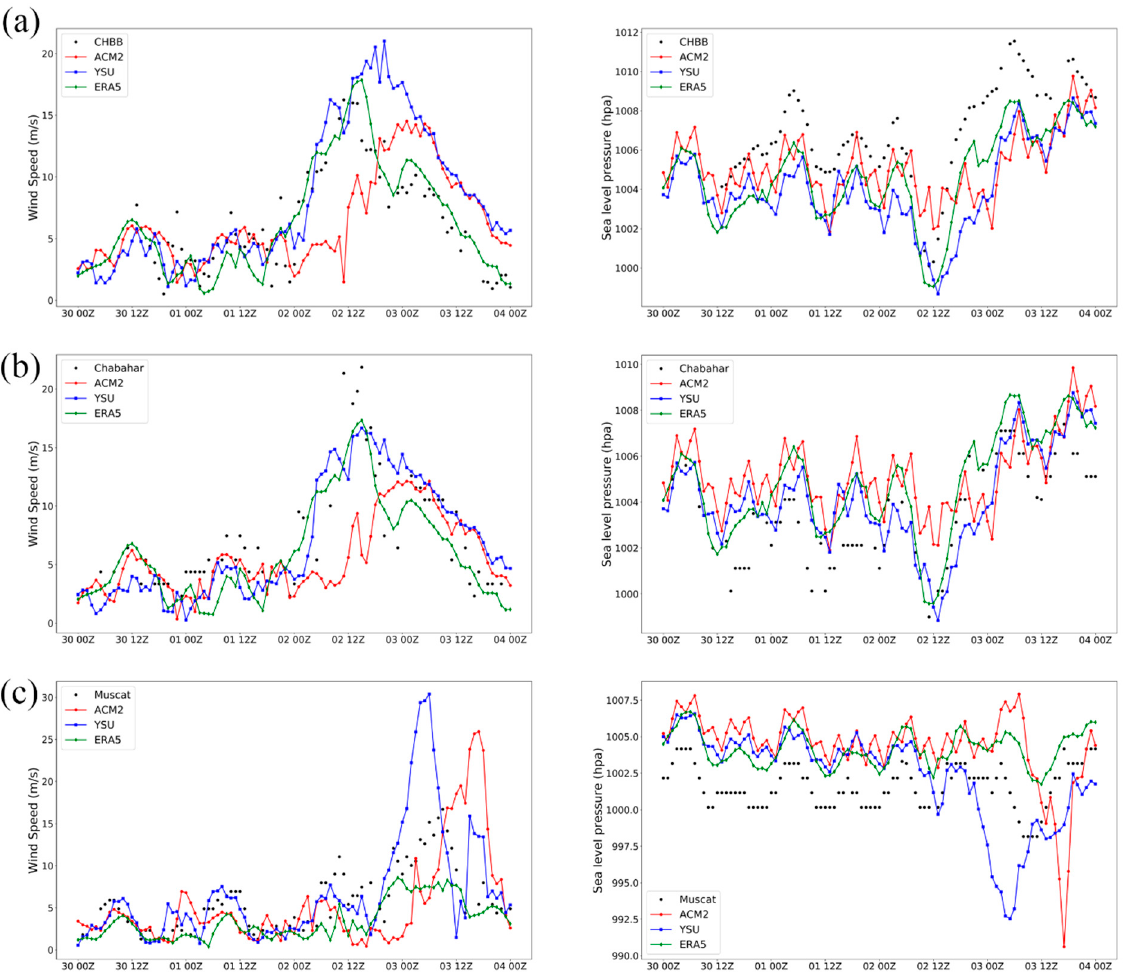
Figure 6. Simulated wind speed ( m ) and sea level pressure (hPa) against observed and ERA5 data at ( a ) Chabahar buoy, ( b ) Chabahar International Airport, and ( c ) Muscat International Airport. Similar to the sea level pressure at Chabahar buoy, ACM2 outperformed YSU Variations in MBE versus RMSE and d for sea level pressure and wind speed at Chabahar buoy and airport stations (Chabahar and Muscat) as a result of the ACM2 and YSU schemes and ERA5 are presented in Figure 7. Although both ACM2 and YSU resulted